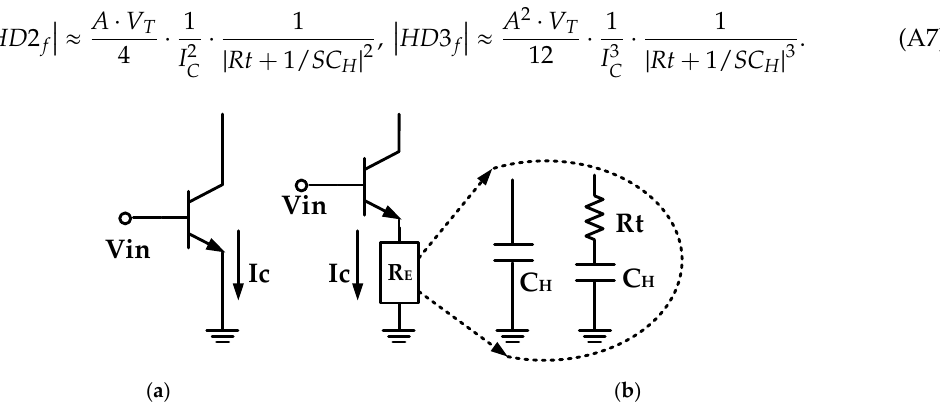
Figure A2. The relationship between I C and Vin : ( a ) without negative feedback; ( b ) with emitter negative feedback impedance R E , which consists of sampling capacitor, C H , in traditional design, Rt , and C H in the proposed